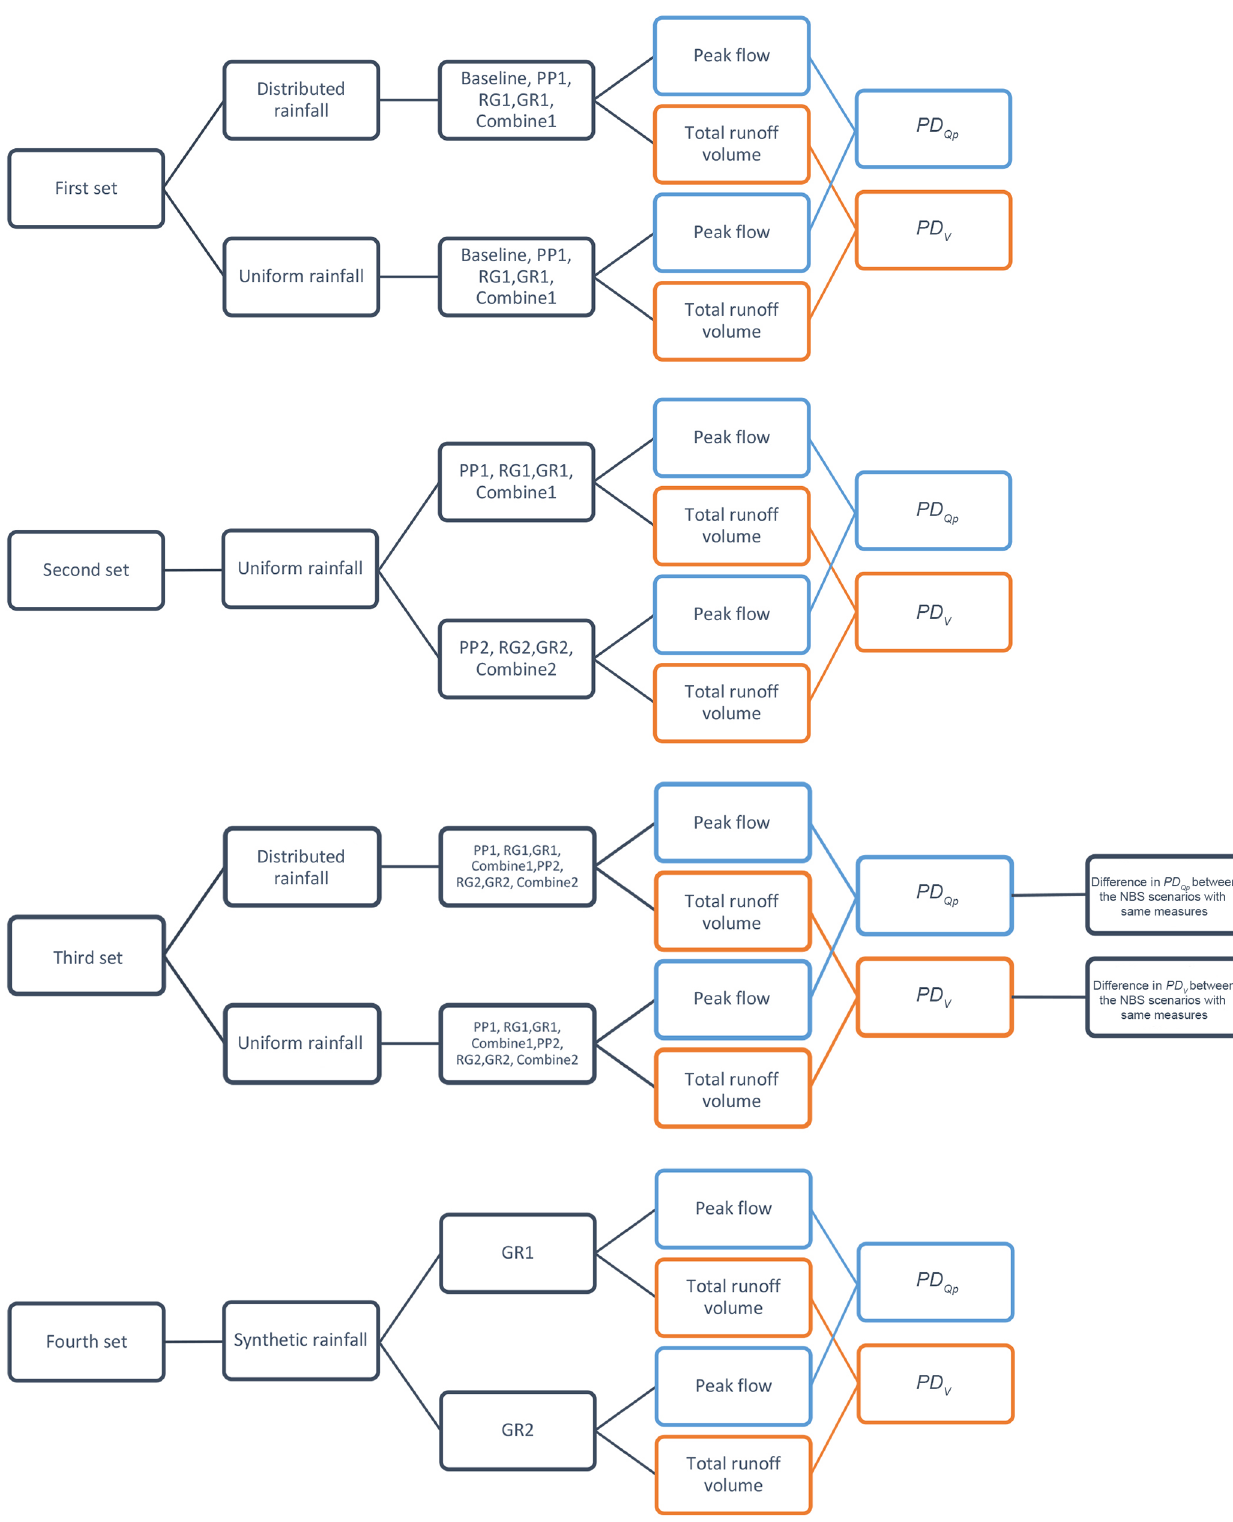
Figure 9. Flow chart of the four sets of modelling